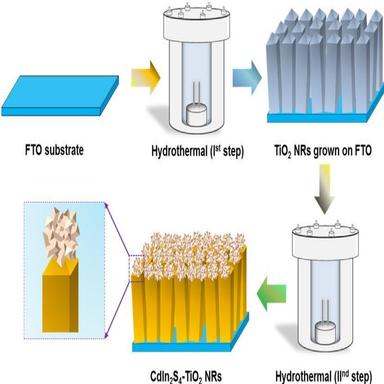
Schematic diagram representing the synthesis of CdIS/TONR/FTO heterostructure.